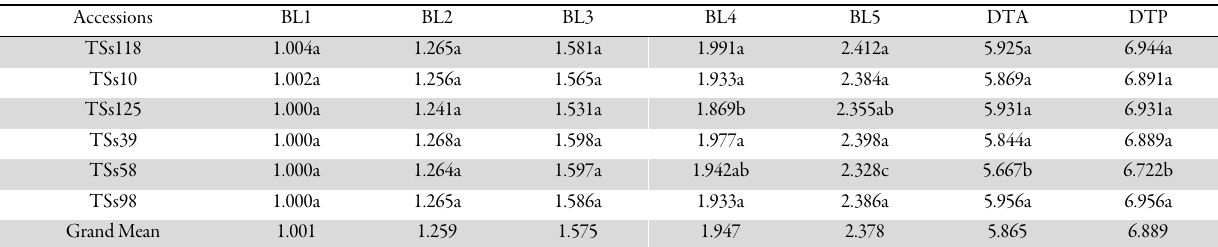
Table 3. Mean of floral bud lengths of different ages